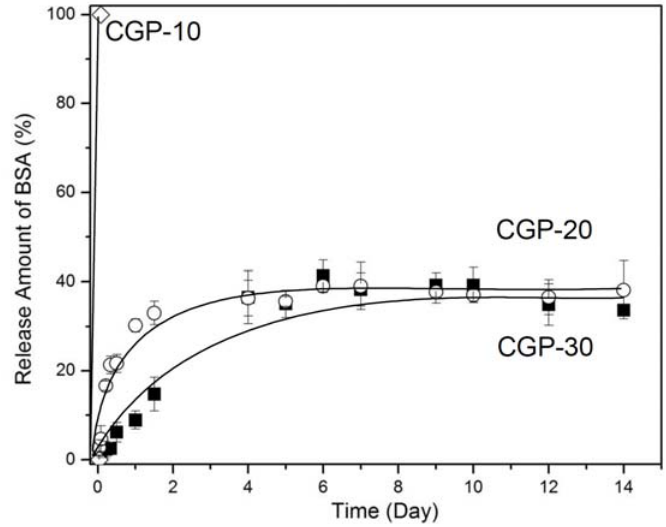
Figure 5. Cumulative amount of BSA-FITC released in vitro from BSA-FITC-loaded CGP-10, CGP-20 and CGP-30 over 14